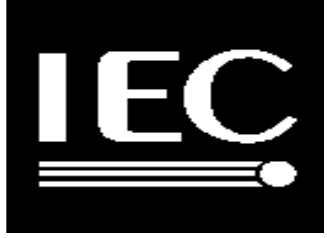
Fig. 5. IEC- International Electro Technical